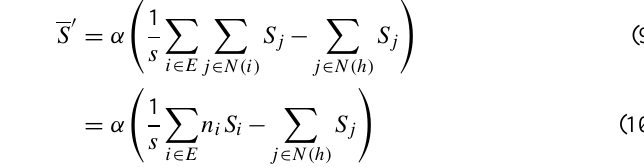
Fig. 3. Decay of the mean supercritical force excess S in six se- quences of asperity events for α = 0 . 2. The dashed line corresponds to the theoretical decay according to S(t) ∼ exp ( − 2 . 55 t)